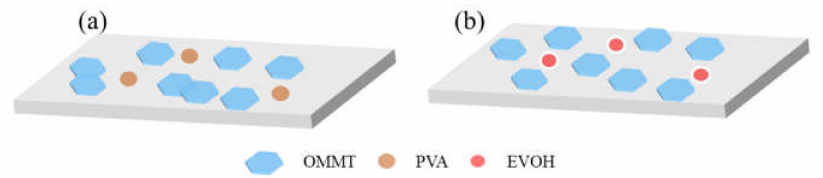
Scheme 2. Intercalation and compatibility effect of ( a ) PLA/PVA/OMMT and ( b ) PLA/EVOH/OMMT